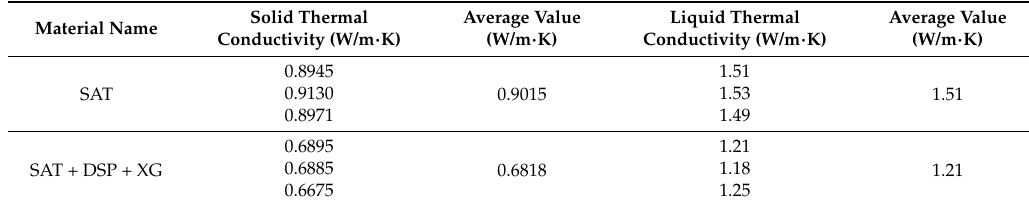
Table 1. Thermal conductivity values of solid liquid materials.